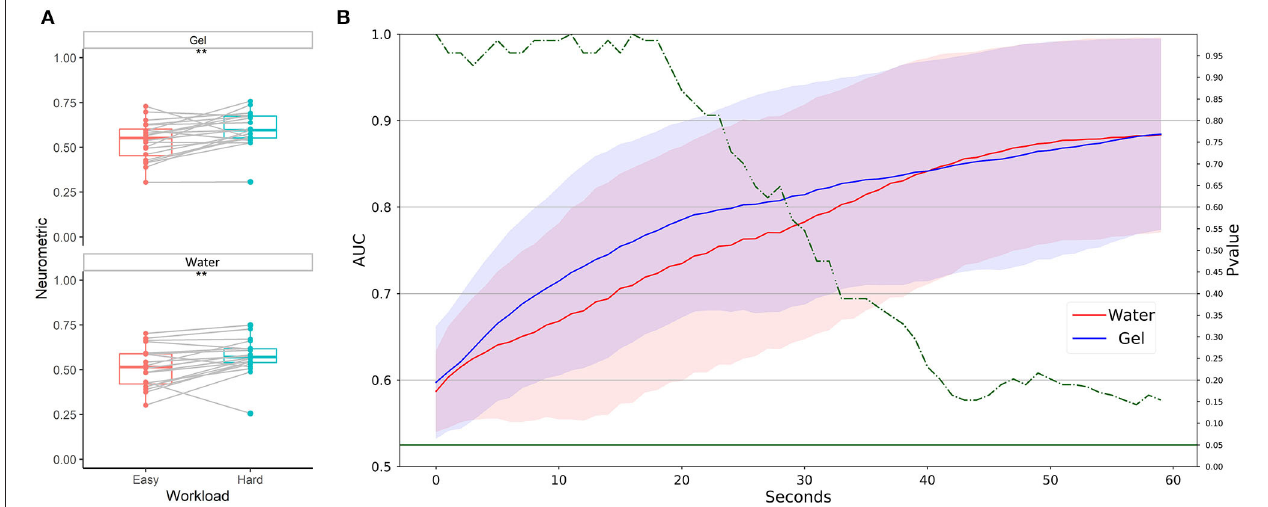
FIGURE 9 | Workload discrimination between easy and hard conditions in a realistic setting. (A) Statistical comparison has been performed for water-based and gel-based Neurometrics. The asterisks show the results of the Wilcoxon signed-rank test (** p < 0.01). (B) AUC values obtained by water (in red) and gel (in blue) electrodes for different time resolutions (1–60s). The solid lines represent the median of the AUC among the participants. The shadows represent the mean absolute deviation of the AUC across participants. The dashed green line represents the results in terms of p -values of the Wilcoxon signed-rank test. The threshold of significance ( p = 0.05) has been highlighted in the same